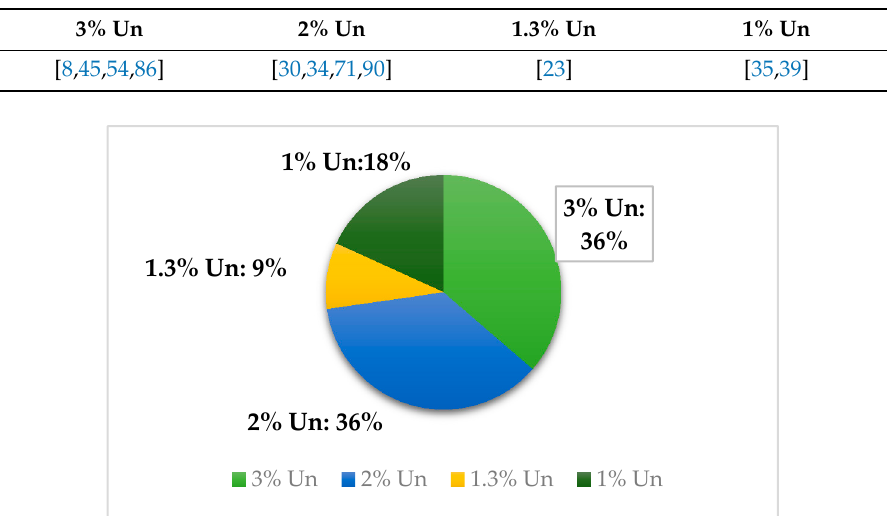
Figure 4. Percentages of Voltage Unbalance limits employed in literature depicting 2% Un and 3% Un as the most pronounced limits.